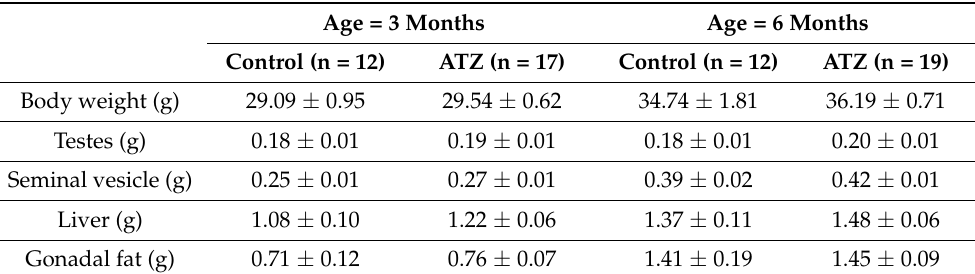
Table 2. The effect of atrazine-treated water (0.02 ng/mL) on body weight (g) and organ weights (g) at 3 and 6 months of age in the F2 cohort. No significant differences were found between the control and ATZ treatment for all parameters. Data are mean ± SEM, with > 7 L per treatment, per age